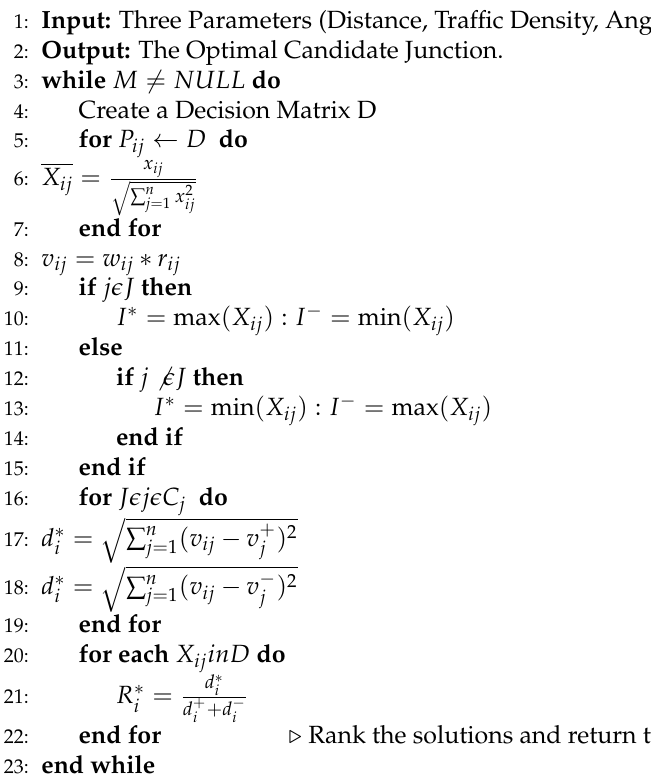
Algorithm 1 Junction Selection-based